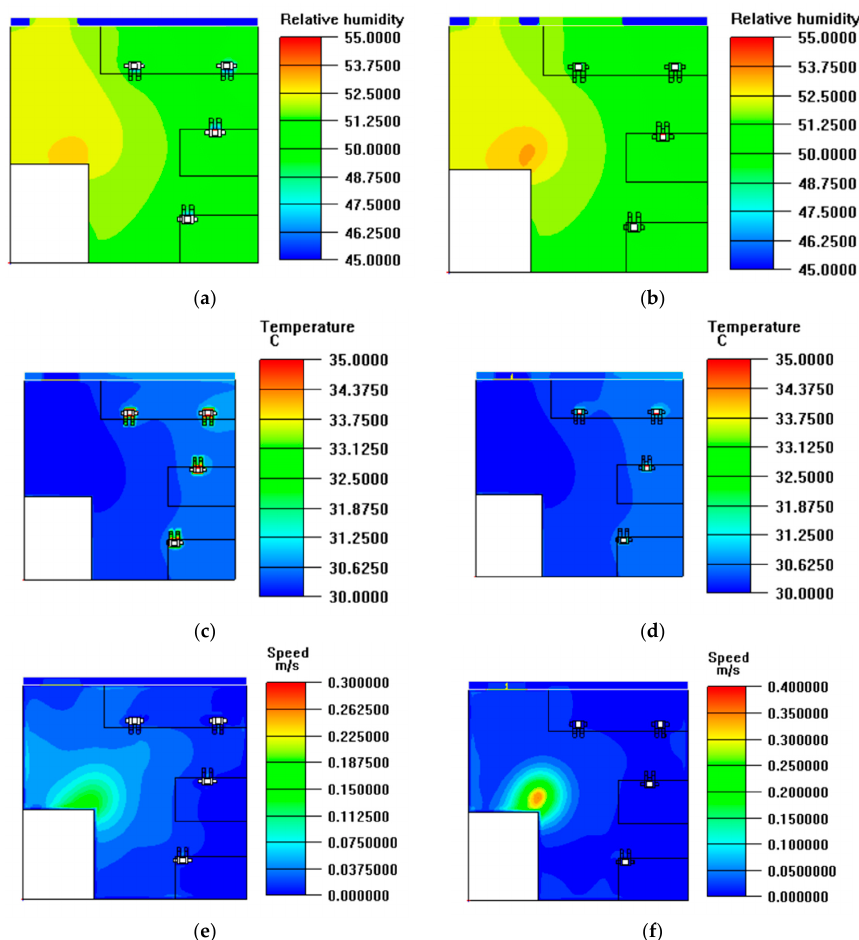
Figure 13. Indoor environment Simulation under mechanical ventilation. ( a ) indoor RH distribution cloud map of the 0.6 m height section; ( b ) indoor RH distribution cloud map of the 1.2 m height section; ( c ) indoor T a distribution cloud map of the 0.6 m height section; ( d ) indoor T a distribution cloud map of the 1.2 m height section; ( e ) indoor WS distribution cloud map of the 0.6 m height section; ( f ) indoor WS distribution cloud map of the 0.6 m height section.